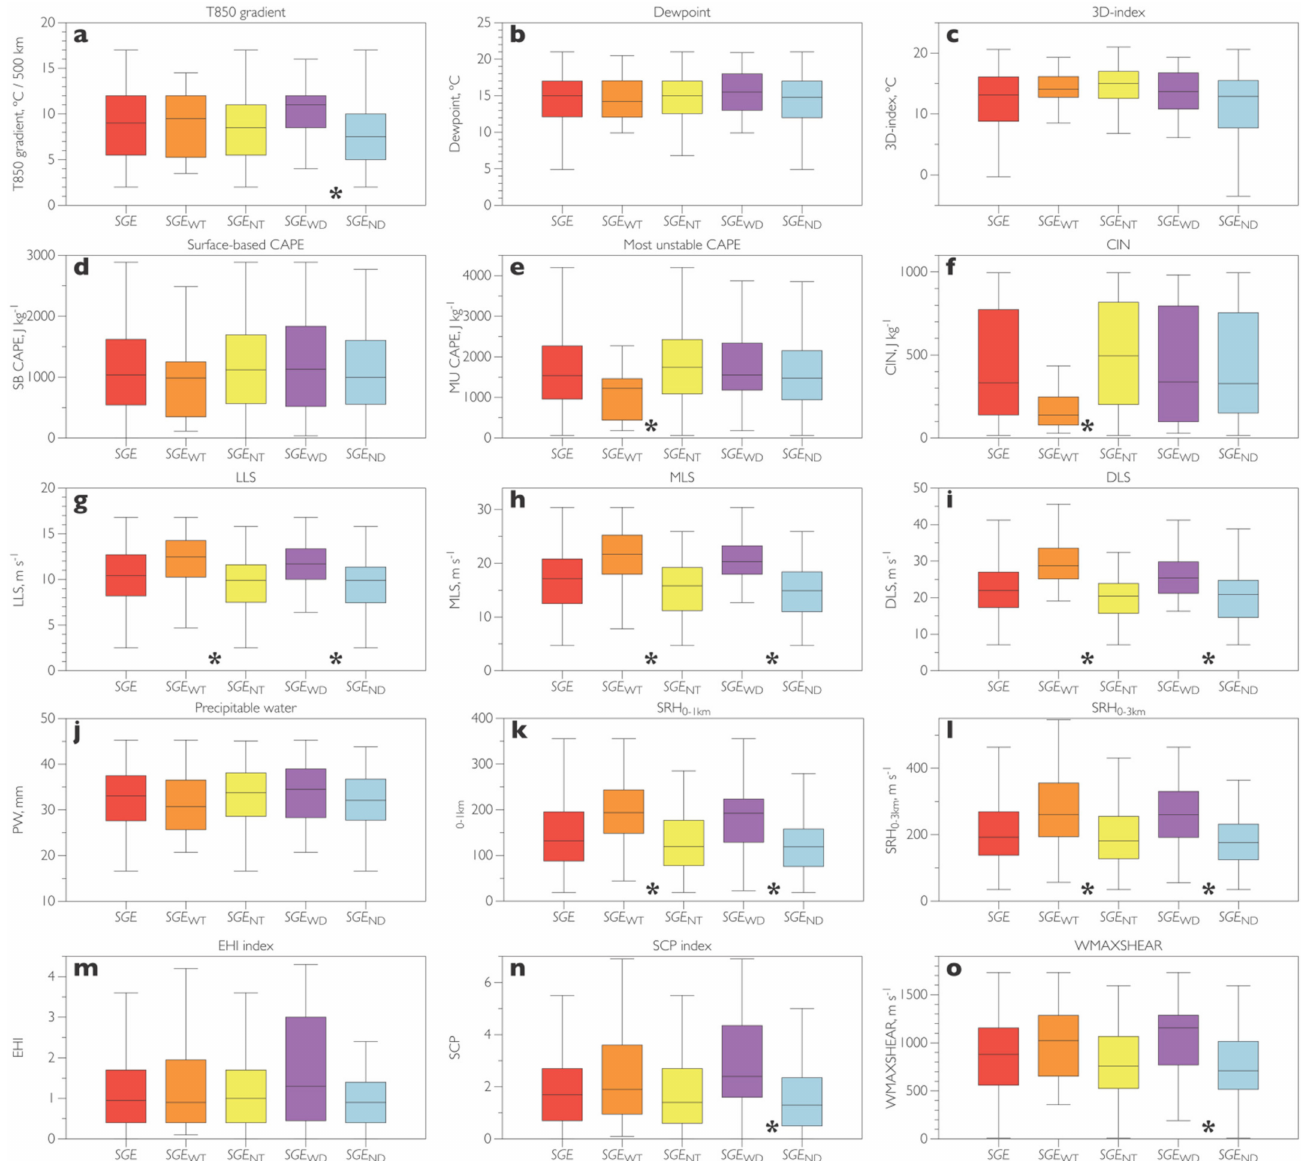
Figure 8. Box and whisker plots for major indicators and parameters of convective instability for SGE (red), SGE WT (orange), SGE NT (yellow), SGE WD (purple), and SGE ND (blue): ( a ) T850 gradient, ( b ) dewpoint, ( c ) 3D index, ( d ) SB CAPE, ( e ) MU CAPE, ( f ) SB CIN, ( g ) LLS, ( h ) MLS, ( i ) DLS, ( j ) PW, ( k ) 0–1 km SRH, ( l ) 0–3 km SRH, ( m ) EHI, ( n ) SCP, ( o ) WMAXSHEAR. Asterisks show statistically significant differences in the mean of the distributions (at 0.05 level) between SGE WT and SGE NT , or between SGE WD and SGE ND based on the K-S